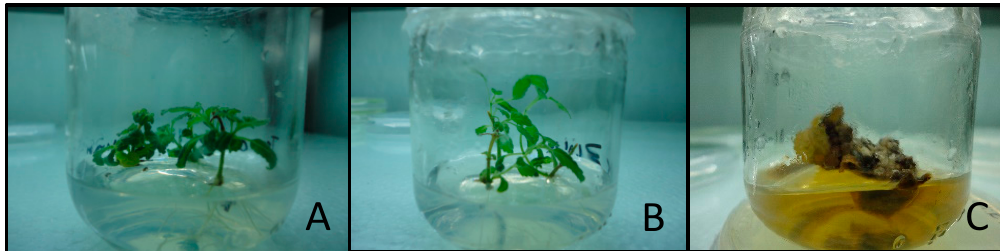
Figure 2. Lippia graveolens explants at different exposure times of mutagenesis treatment (0.3% ethyl methane sulfonate (EMS)): 1 ( A ), 2 ( B ) and 3 ( C ) h.